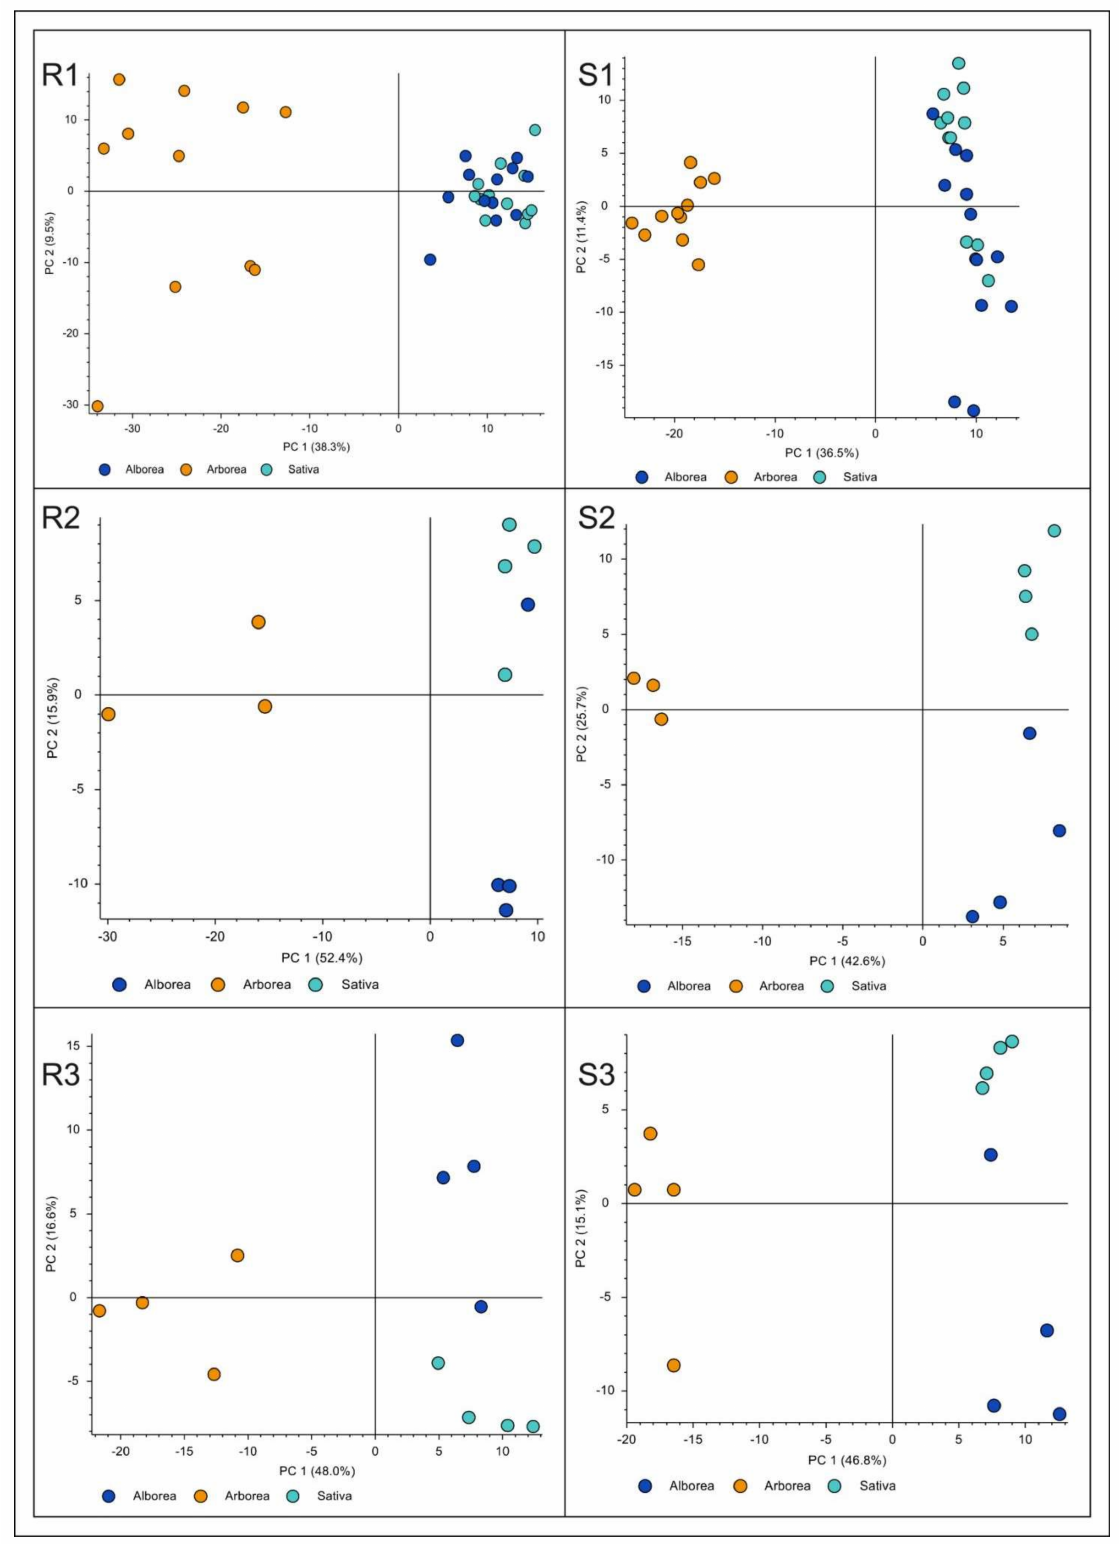
Figure 3. Principal component analysis (PCA) score plots of secondary metabolic profiles in Medicago entries: (R1 & S1) PCA score plots of the average for all the treatments, i.e., control, 100 mM, 50-75-100 mM, in roots and shoots, (R2 & S2) PCA score plot for, 100 mM in roots and shoots, (R3 & S3) PCA score plot for 50-75-100 mM in roots and shoots. M. sativa (light blue), M. arborea (yellow) and Alborea (dark